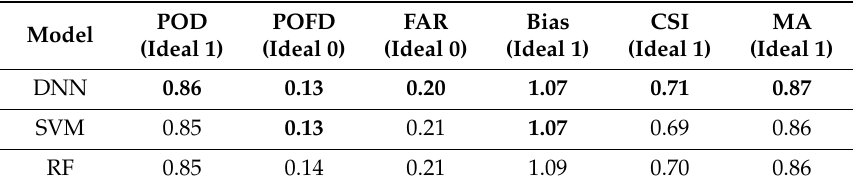
Table 5. Validation of rainy cloud detection model on testing data. The best result for each assessor is shown in bold. POD is the Probability of Detection; POFD is the Probability of False Detection; FAR is False Alarm Ratio; CSI is the Critical Success Index; MA is the Model Accuracy; DNN is Deep Neural Network; SVM is Support Vector Machine; RF is Random Forest.